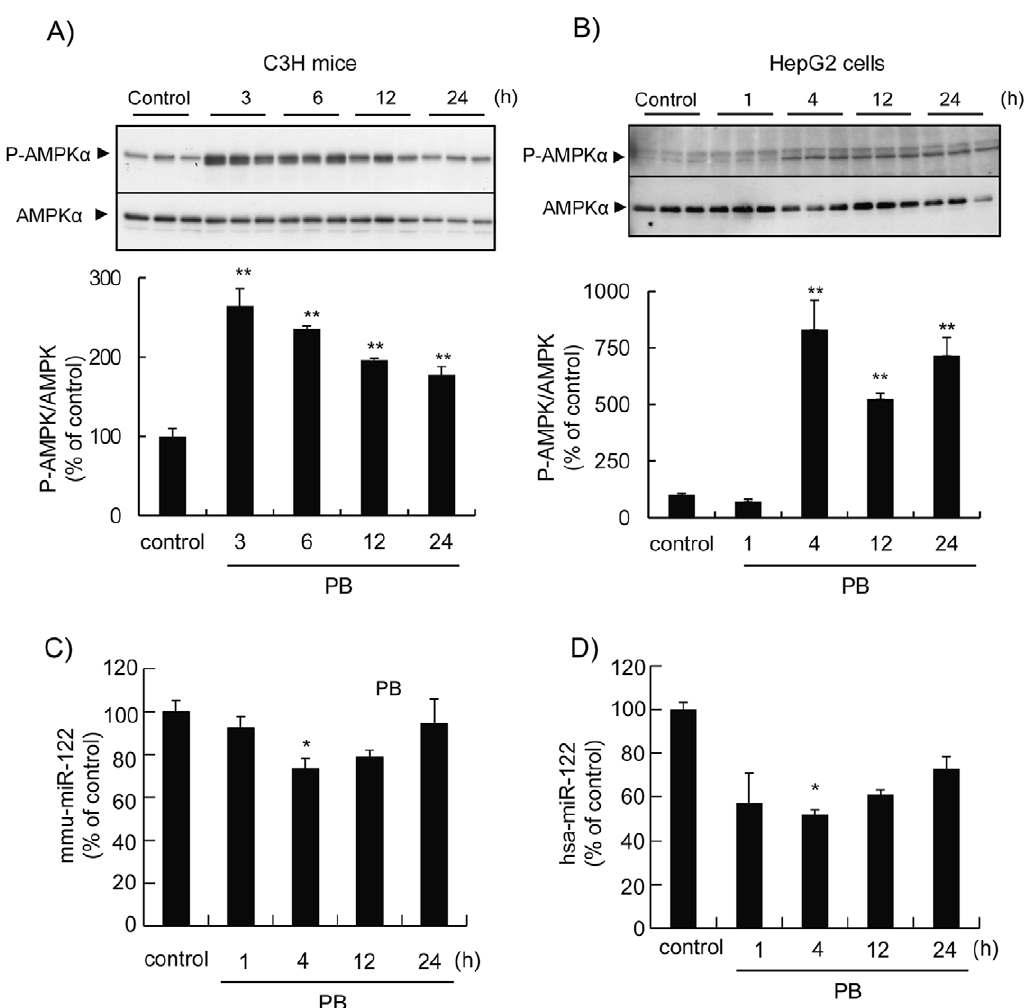
Figure 1. PB induces reciprocal changes in AMPK activation and miR-122 down-regulation. A and C , Male C3H/HeN mice were treated with PB (100 mg/kg, ip .) and sacrificed times as indicated. B and D , HepG2 cells were treated with 1 mM PB for times as indicated. Activated AMPK protein levels in the post mitochondrial fraction of the liver ( A ) and total cell lysate ( B ) were determined by Western blot analysis using phospho- AMPK a (Thr 172) specific antibody. The blot was sequentially probed with the AMPK a antibody. The closed arrow heads indicate phospho-AMPK a (P- AMPK a )- and total AMPK a -derived bands. Densitometric data from phospho-AMPK a were normalized by total AMPK a and a relative increase is shown. Total RNA samples from mouse liver ( C ) and HepG2 cells ( D ) were subjected to quantitative RT-PCR using a TaqMan probe for mouse (mmu-) and human (hsa-) miR-122, respectively. Data were normalized with the respective U6 snRNA. Data represented are the % of the control group (n=3). *, p ,